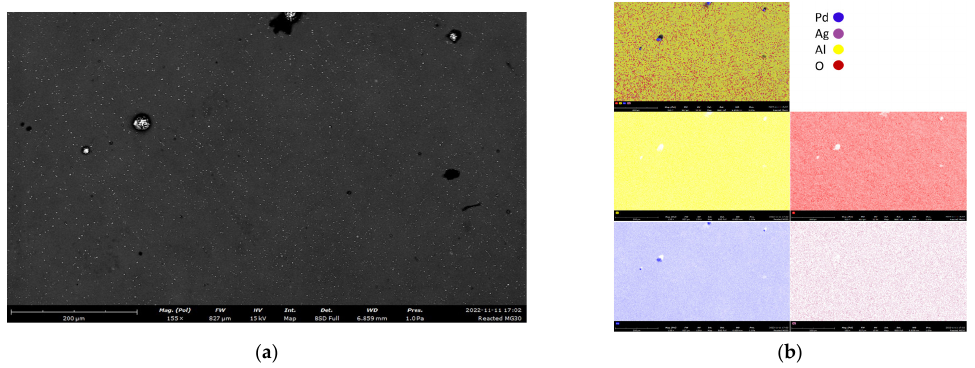
Figure 3. SEM ( a ) and EDX ( b ) image of the cross-section of the double-skinned Pd–Ag membrane used in this work.